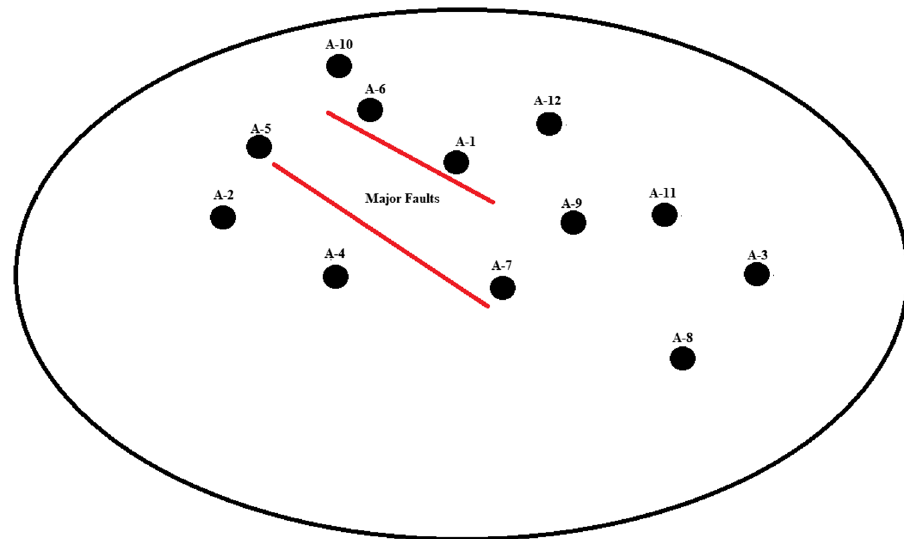
Fig. 1 Schematic well locations of reservoir ‘A’ (not in